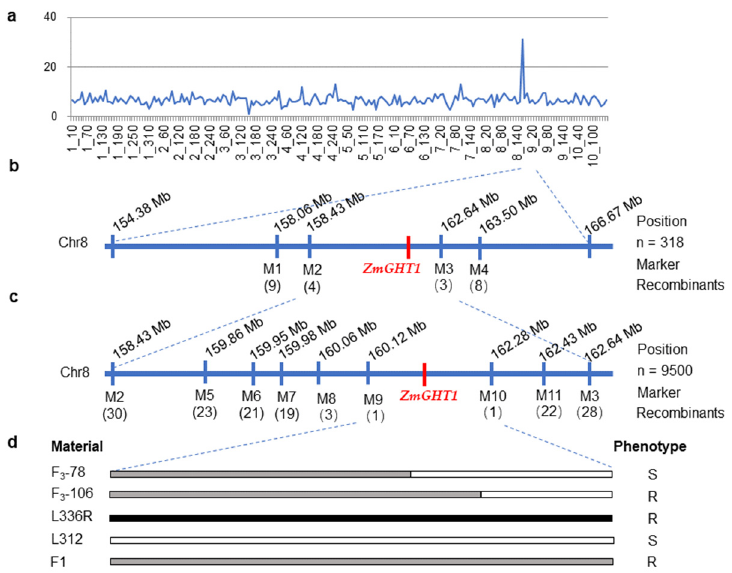
Figure 2. Fine mapping of ZmGHT1 . ( a ) Polymorphic ratios between tolerant and sensitive DNA pools detected by the Maize 60K SNP chip; ( b ) primary mapping of ZmGHT1 , and the ZmGHT1 region was delimited to a 4.21 Mb interval between M2 and M3 in Chr8; ( c ) fine mapping of ZmGHT1 , and the ZmGHT1 was mapped between M9 and M10; ( d ) illustration of the key recombinants and phenotype determination. Black bars represent chromosomal fragments derived from L336R, white bars represent the fragments derived from L312, and gray bars indicate the heterozygous